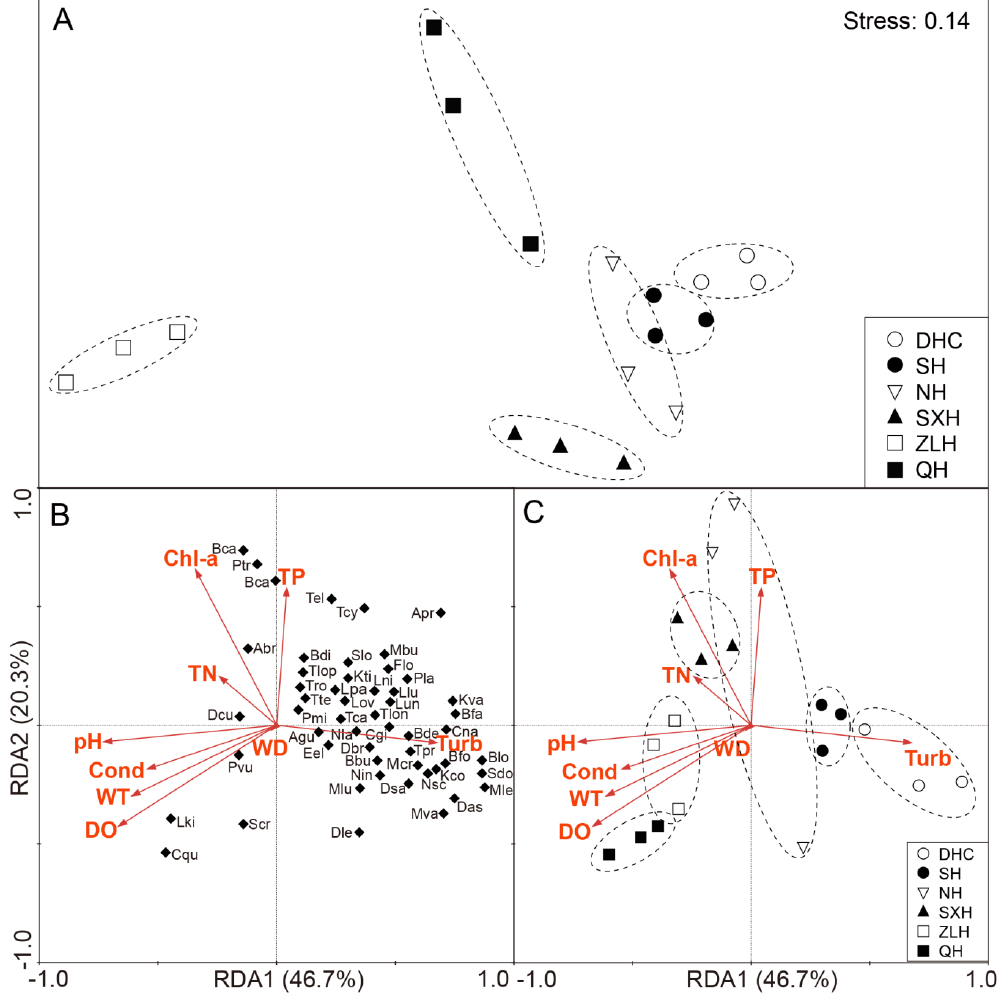
Figure 3. The Redundancy and metric multidimensional scaling ordination (NMDS) analysis of strength and relationship of physicochemical factors and samples from six lakes based on zooplankton distribution. ( A ) NMDS presented variance by the distances between samples. ( B ) RDA showed the relationship of zooplankton distribution and physicochemical factors. The full name of zooplankton species in this panel were presented in Table A1. ( C ) RDA showed the relationship of samples and physicochemical factors. The physicochemical factors: pH, water depth (WT), total nitrogen (TN), total phosphorus (TP), dissolved oxygen (DO), conductivity (Cond), water temperature (WT), turbidity (Turb), chlorophyll a (Chl-a).